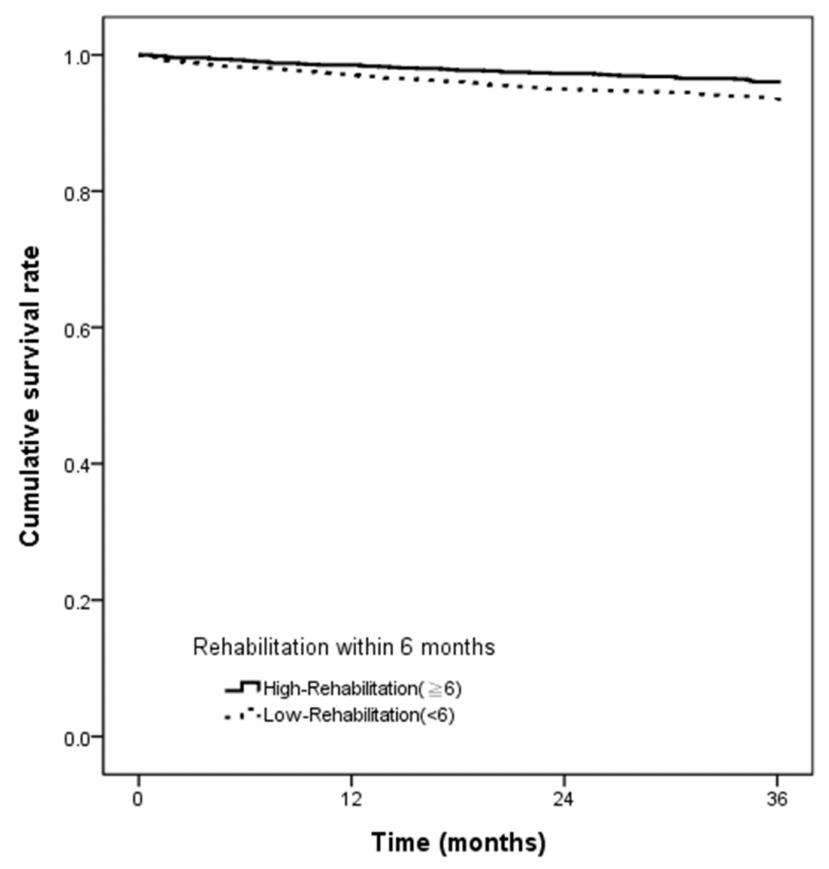
Figure 2. Demonstrated the Kaplan–Meier estimates of survival rate stratified by rehabilitation intensity within 6